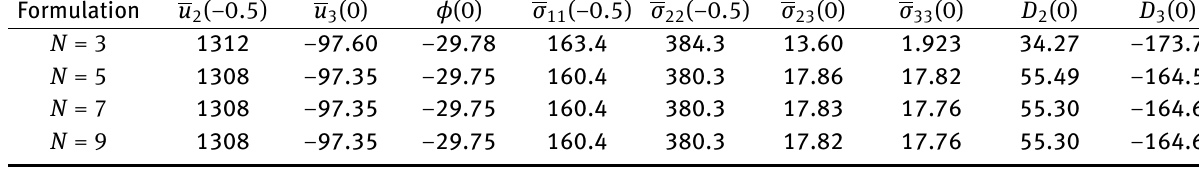
Table 7: Results for a FGM piezoelectric thin cylindrical shell with R / h = 72.75 and α = 1 using 32 × 128 mesh. Formulation